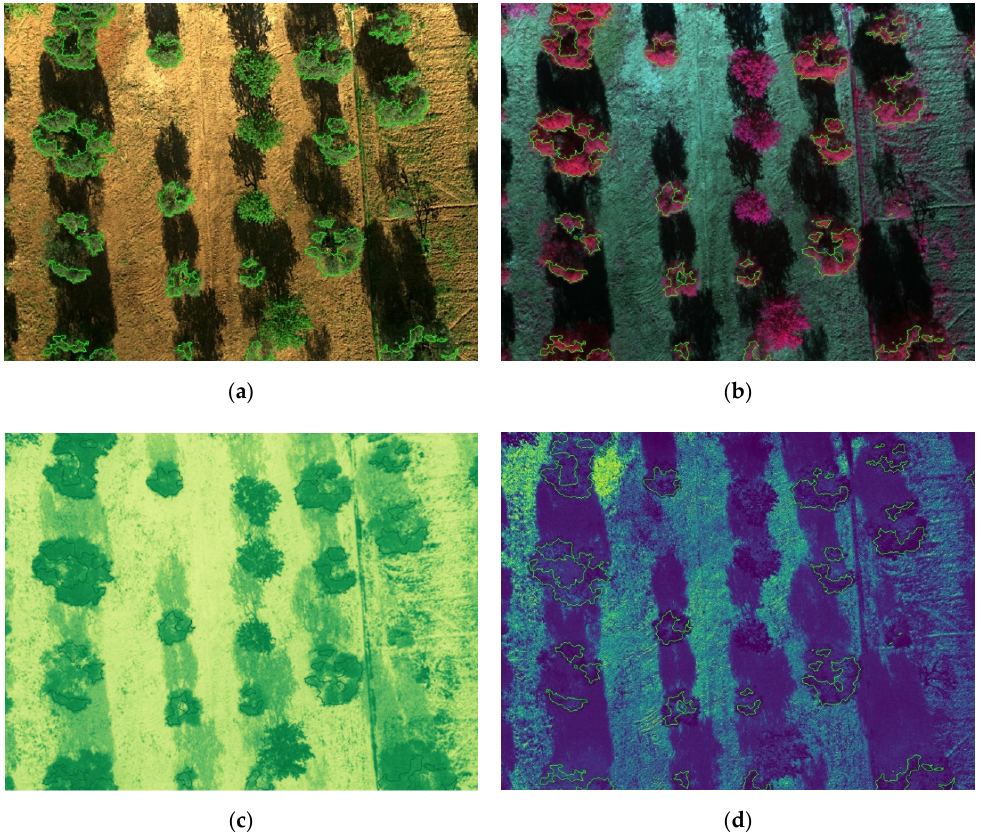
Figure 13. ( a ) Segmented RGB image; ( b ) segmented CIR image; ( c ) NDVI image; ( d ) probability map. A few trees that were not olive trees were excluded from processing.